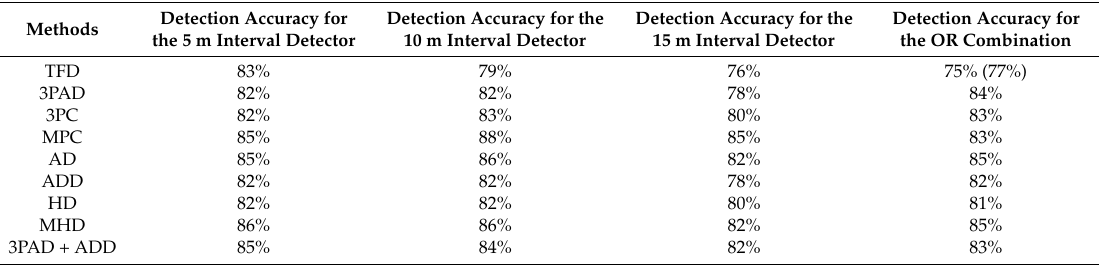
Table 1. The detection accuracies of each detector separately and for the OR combination.